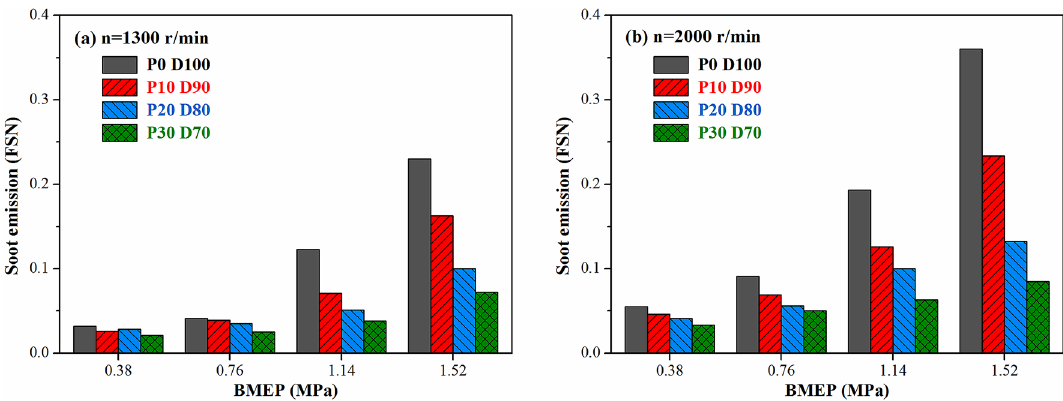
Figure 12. Effects of PODE n blending ratio on soot